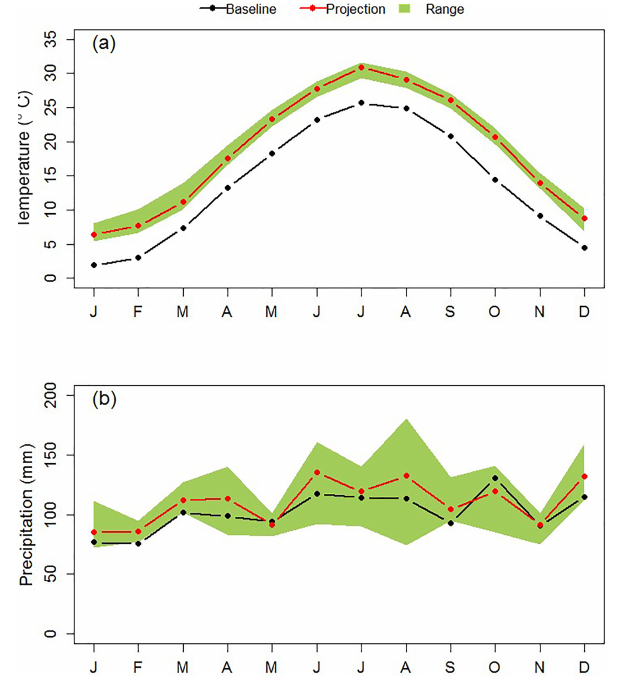
Figure 7. Monthly average of (a) mean temperature and (b) cumu- lative precipitation for the baseline (2001–2014) and future (2085– 2098) periods. Note: “Projection” stands for the ensemble mean of five GCM data, and the range stands for the interval between the maximum and minimum values of five GCM